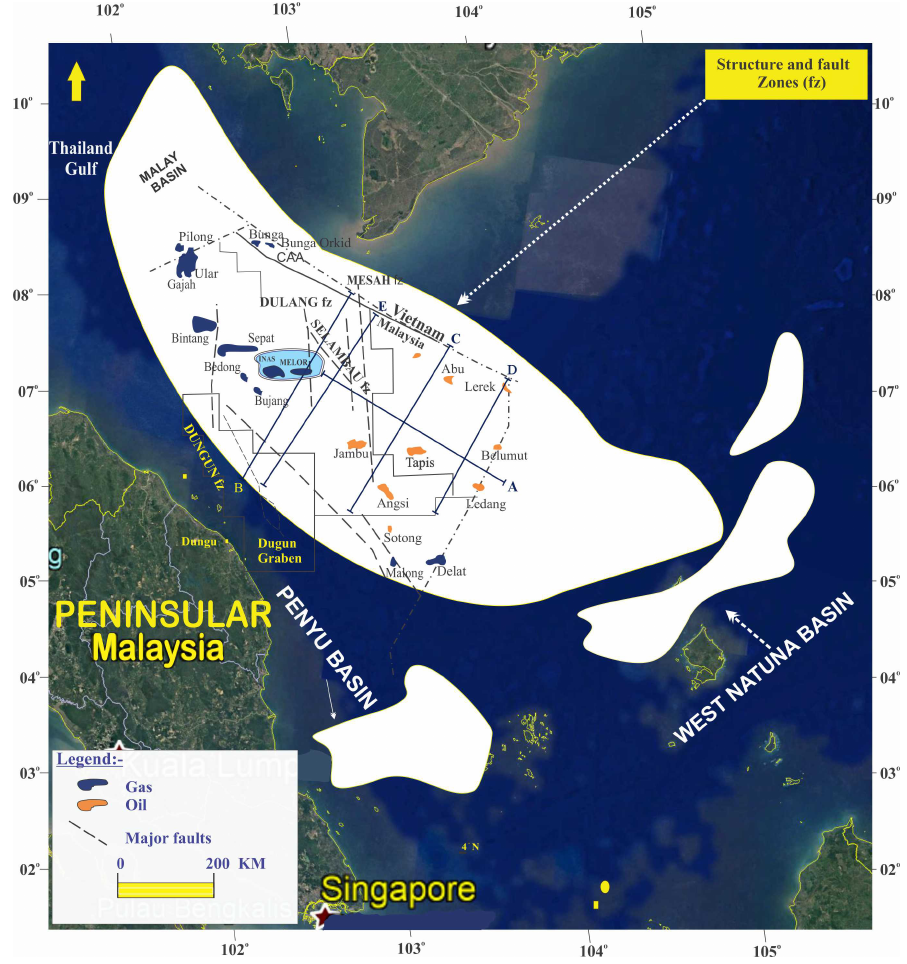
Figure 1. The map of the study area Malay Basin was modified and retraced after Madon (1999) [17].